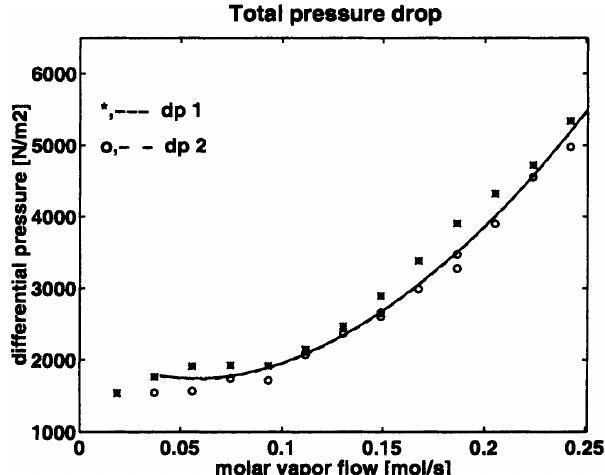
Figure 2. Comparison of measured (*,o) and estimated ( ñ ) pressure drop over the